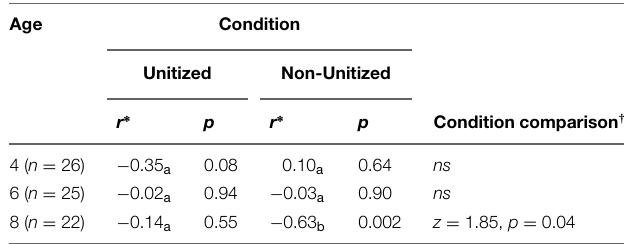
FIGURE 2 | Memory performance for 4-, 6-, and 8-year-old children on unitized and non-unitized memory conditions. Error bars represent standard error of the mean.